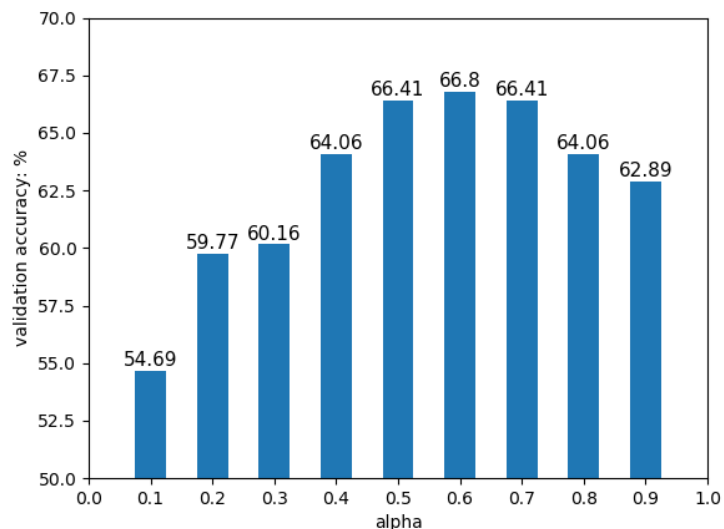
Figure 7. Experiments on different proportions of cross-modal emotion distillation in the total